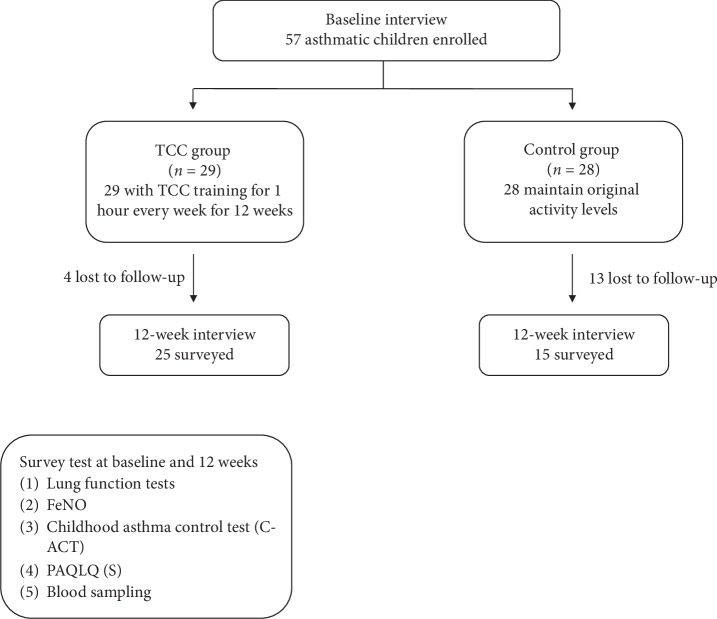
A flowchart of data collection.